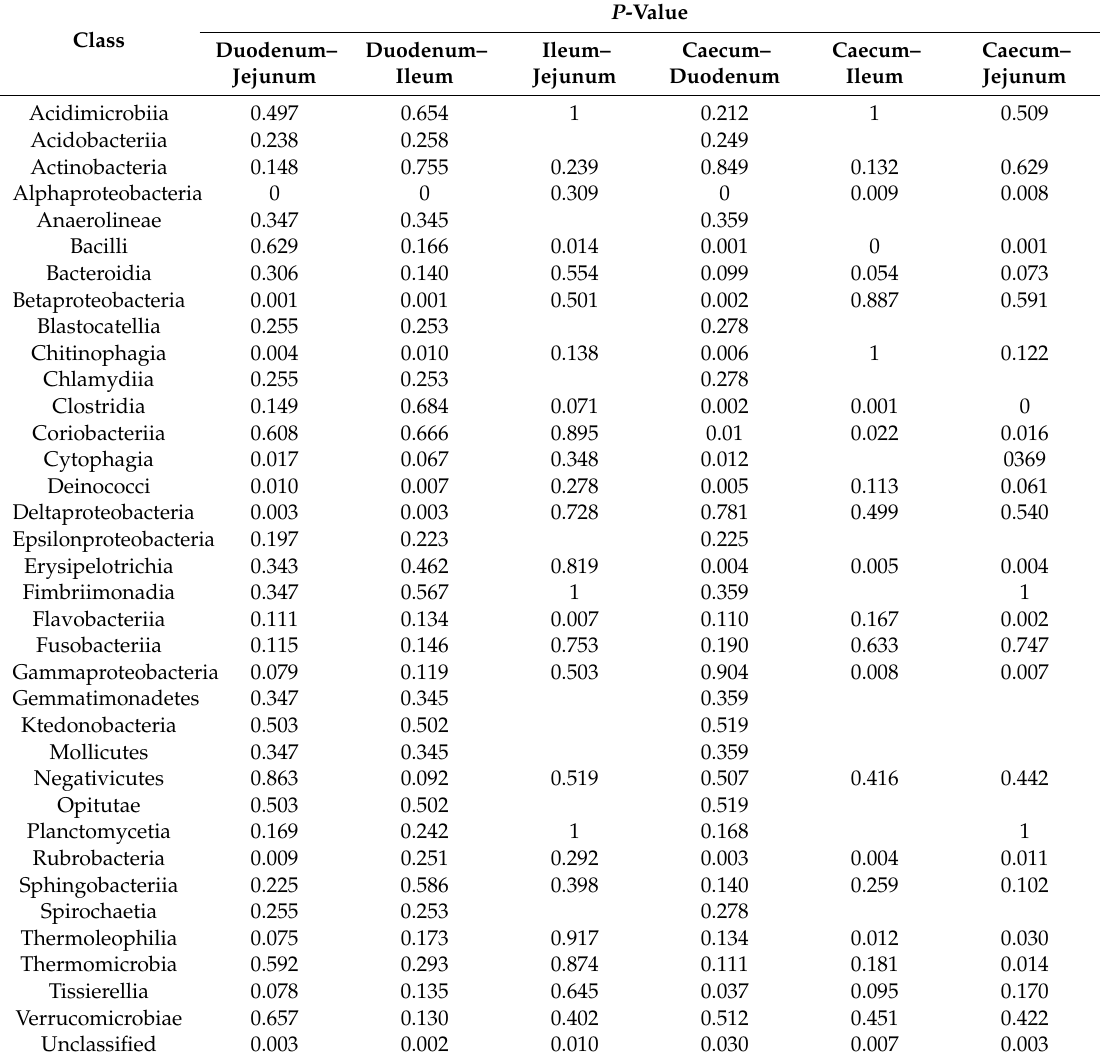
Table 11. P -value distribution of 16S rDNA gene sequence libraries compared the abundance di ff erences of microbial communities among samples from di ff erent segments for local Omani